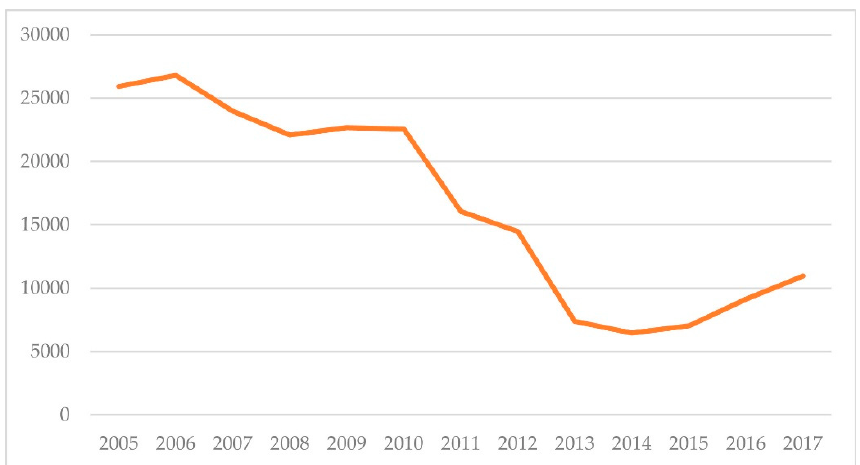
Figure 2. Number of evictions due to non-payment of rental or deposits per year in Spain. Data: General Council of the Judiciary and INE. Own production.